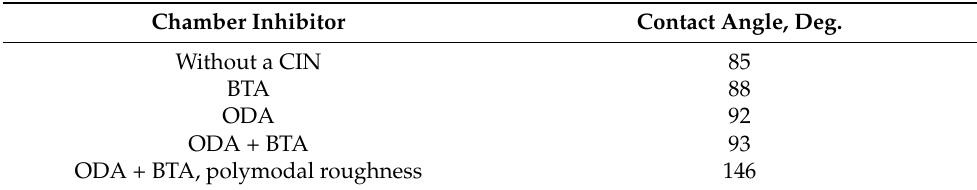
Table 14. Effect of brass CT on the contact angles of wetting with distilled water. T CT = 120 ◦ C, and τ CT = 60 min. Chamber Inhibitor Contact Angle, Deg. Without a CIN 85 BTA 88 ODA 92 ODA + BTA 93 ODA + BTA, polymodal roughness